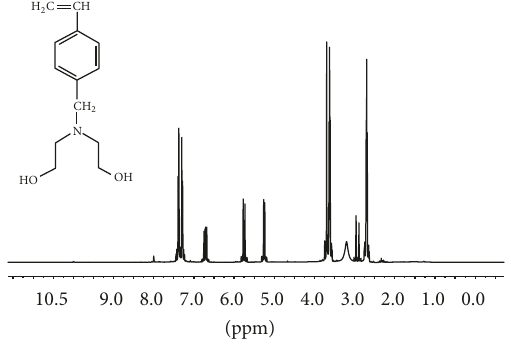
Figure 3: The 1 H-NMR spectrum of DEAMSt monomer.